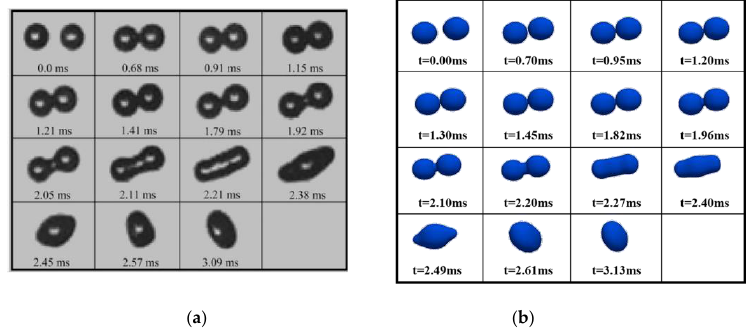
Figure 5. Comparison with the experimental images of Qian et al. [26]: ( a ) the experiment result; ( b ) the simulation result.